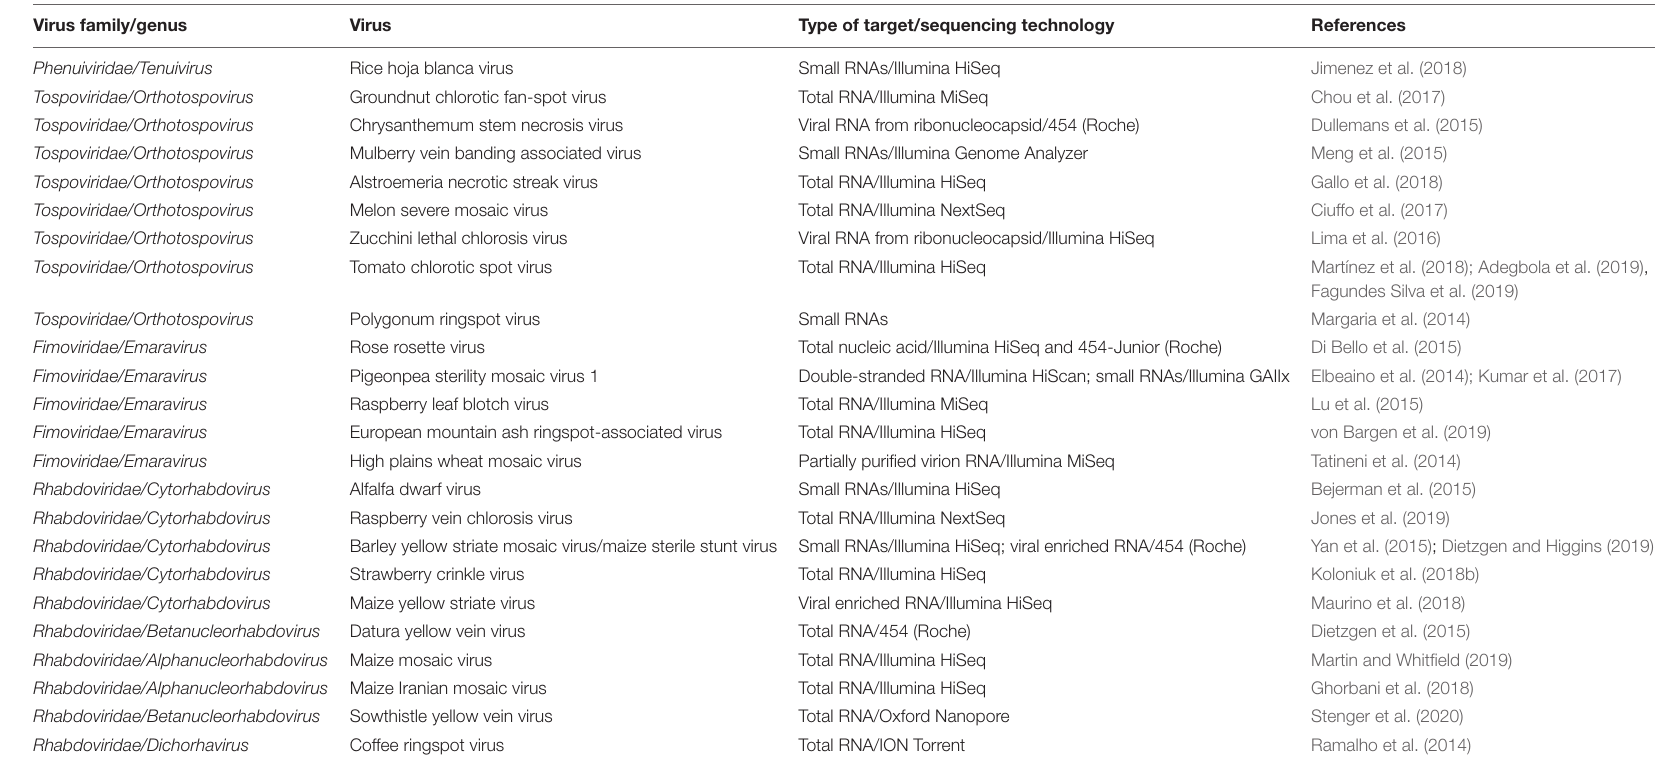
TABLE 2 | NSR viruses with partial genome sequence already know, whose genomes were characterized using